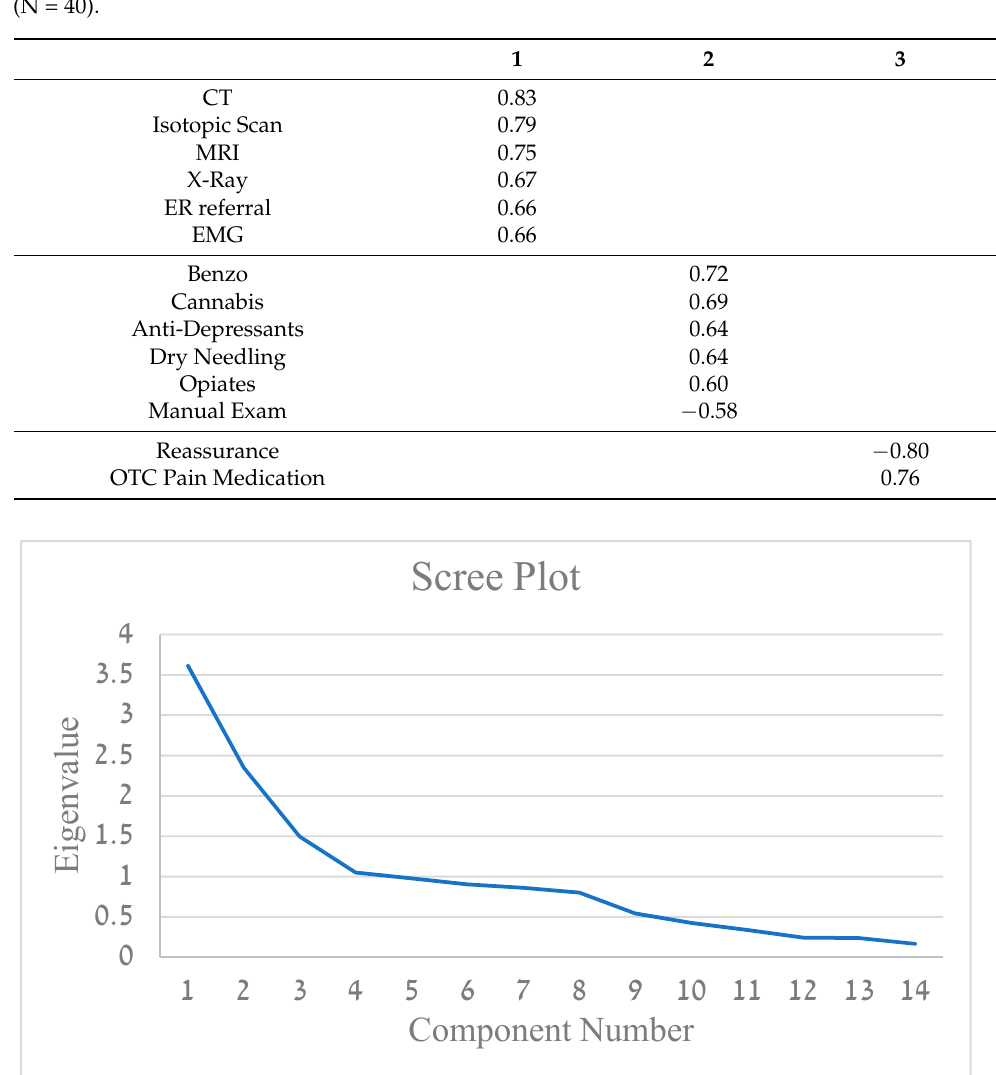
Figure 2. Eigenvalues for components for each of the 14 questions items.